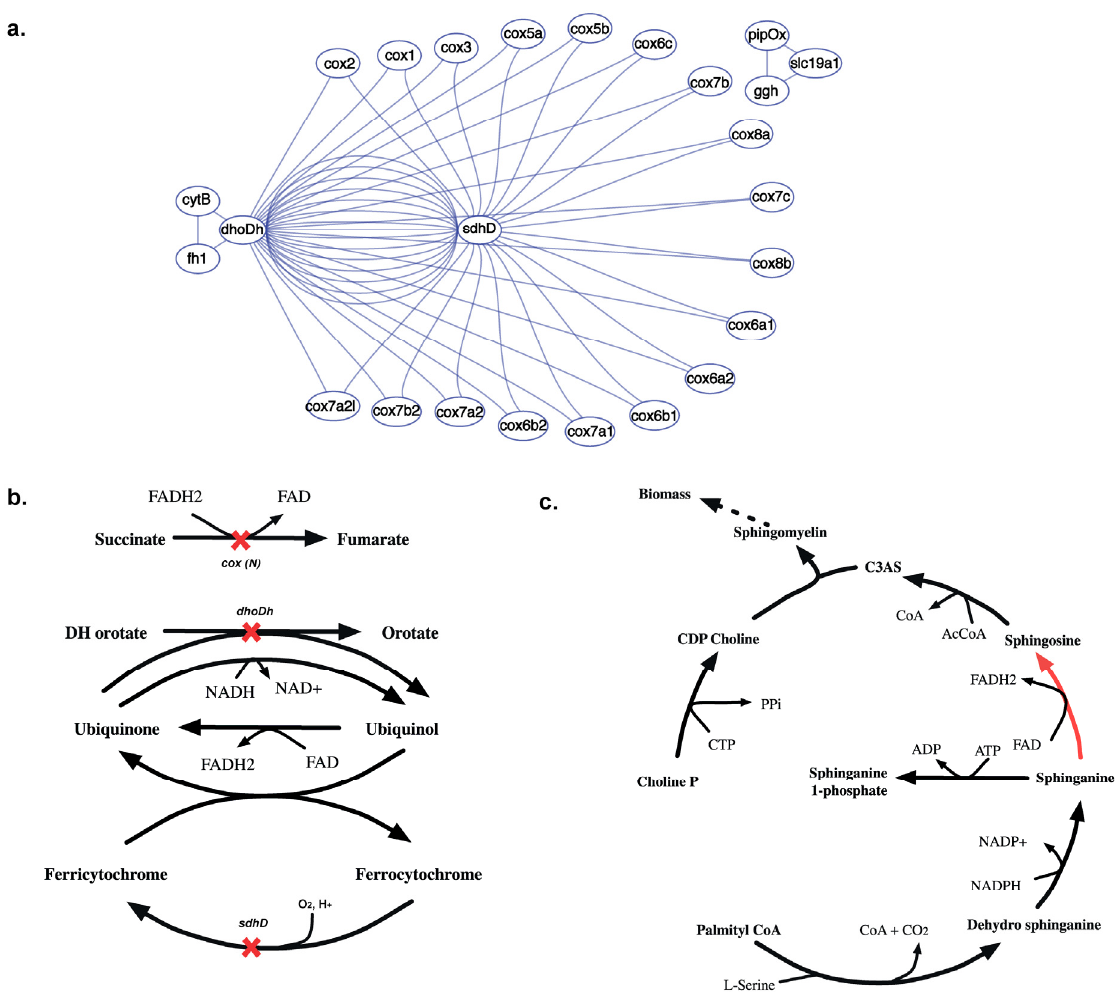
Figure 15. Synthetic lethal interaction of cytochrome oxidase genes. ( a ) Shows the SL3 landscape with in silico SL3 interactions between sdhD, dhoDh and 18 different cox genes. ( b ) Shows the reactions that get knocked out upon in silico removal of dhoDh, sdhD and either of the 18 cox(N) genes, preventing synthesis of cofactors FAD and FADH 2 . ( c ) Shows why the absence of FAD prevents the sphinganine to sphingosine conversion (shown in red) making the removal of gene triplet